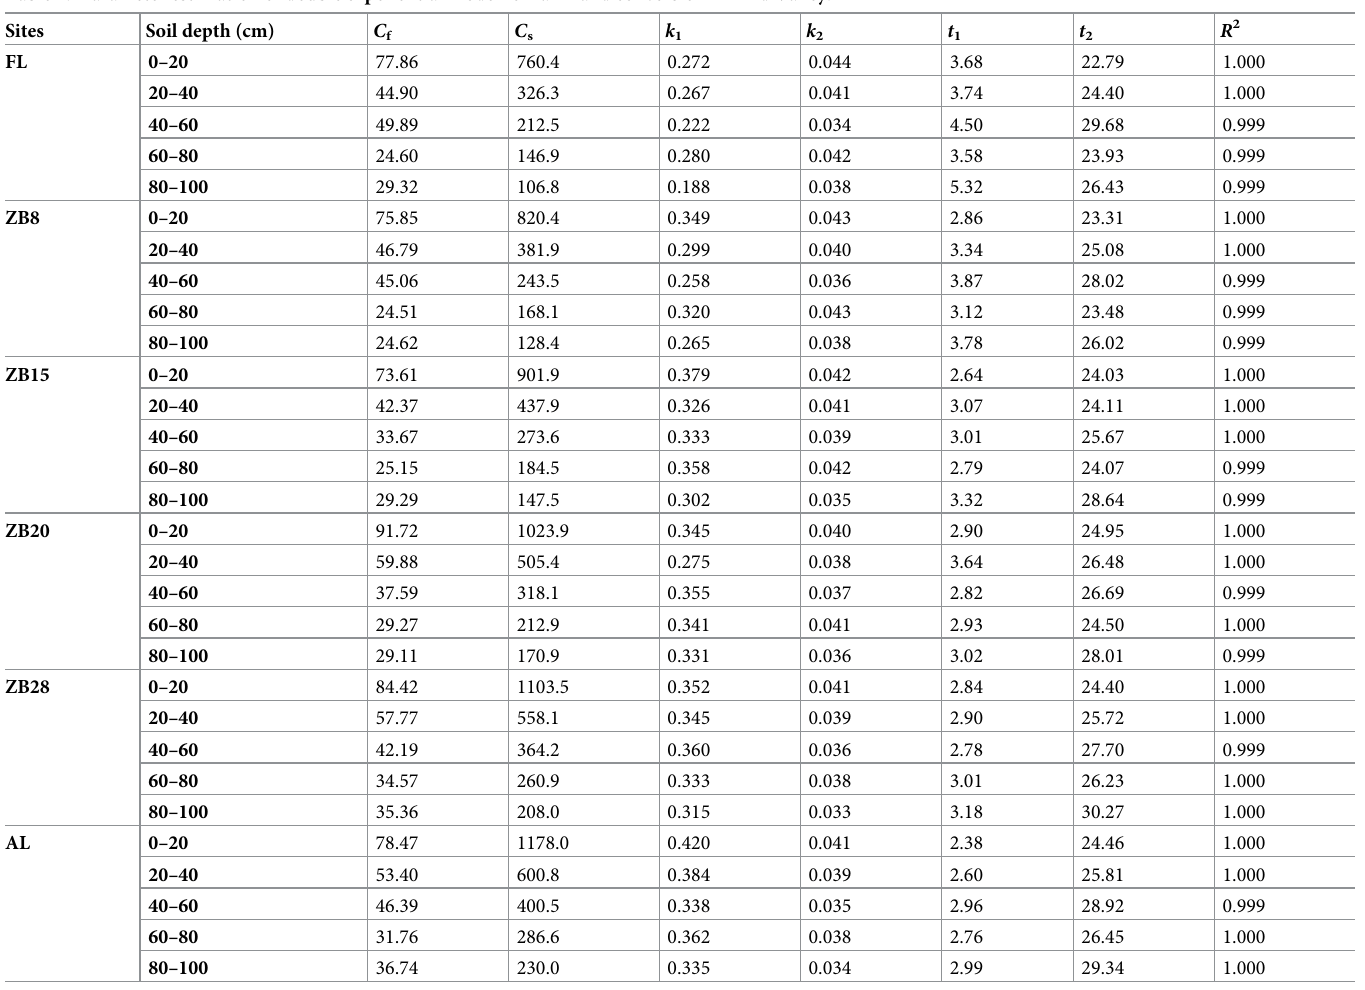
Table 2. Parameter estimation of double exponential model for farmland conversion in Arid